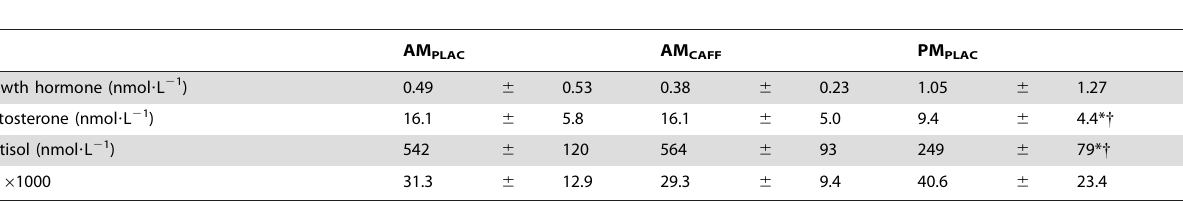
Table 2. Serum blood steroid hormone concentration in the two trials in the morning (9:15 a.m.; AM PLAC and AM CAFF ) before caffeine was ingested and in the afternoon (17:15 pm; PM PLAC